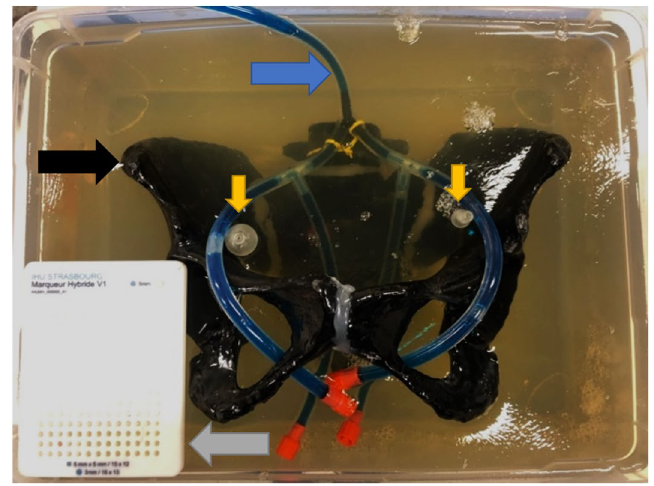
Fig. 1 Phantom model including a 3D-printed pelvis (black), a vascular tree mimicked using standard tubing (blue), two spheres simulating target SLN (yellow), and a calibration device (gray) amalgamated by a gelatin-based support. SLN, sentinel lymph